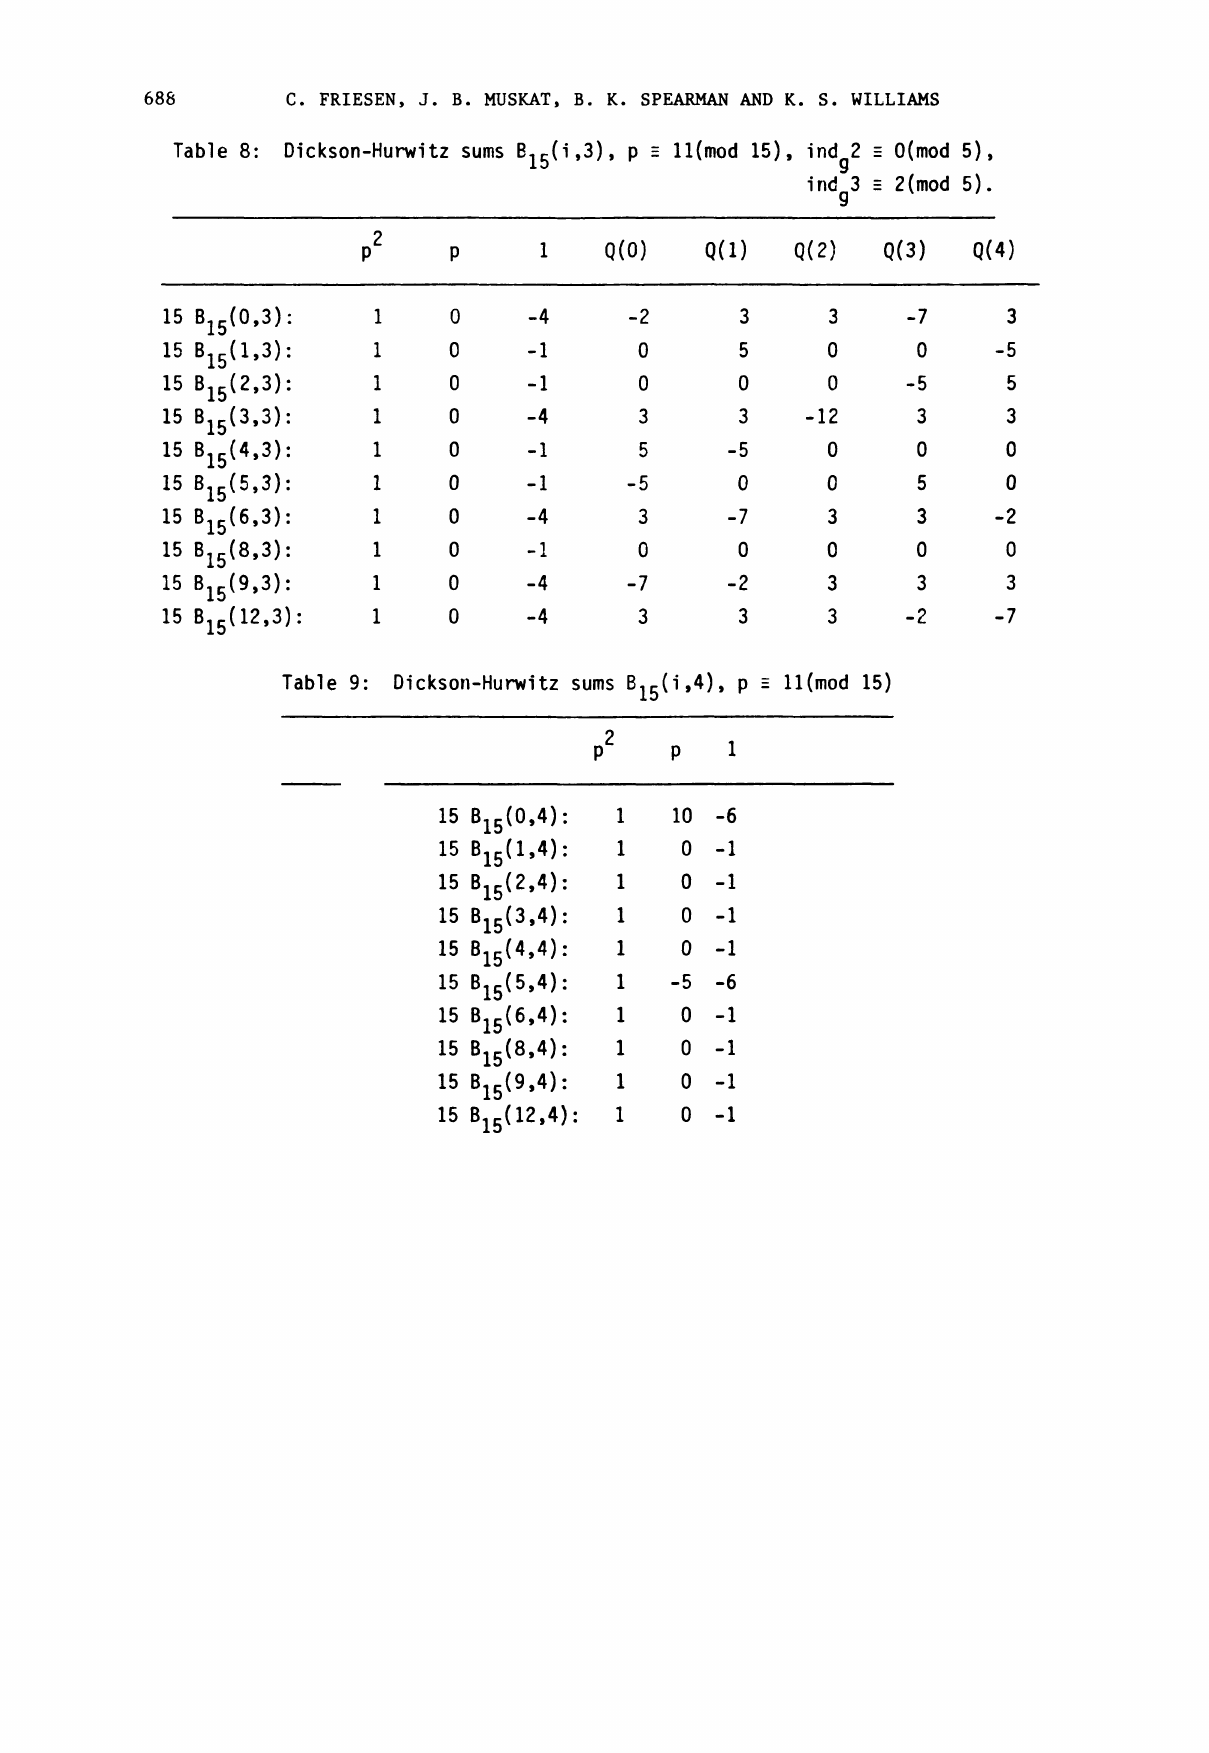
Dickson-Hurwitz sums B15(i,3), p